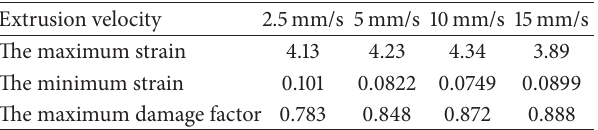
Table 2: The maximum and minimum effective strain and damage factor with different extrusion